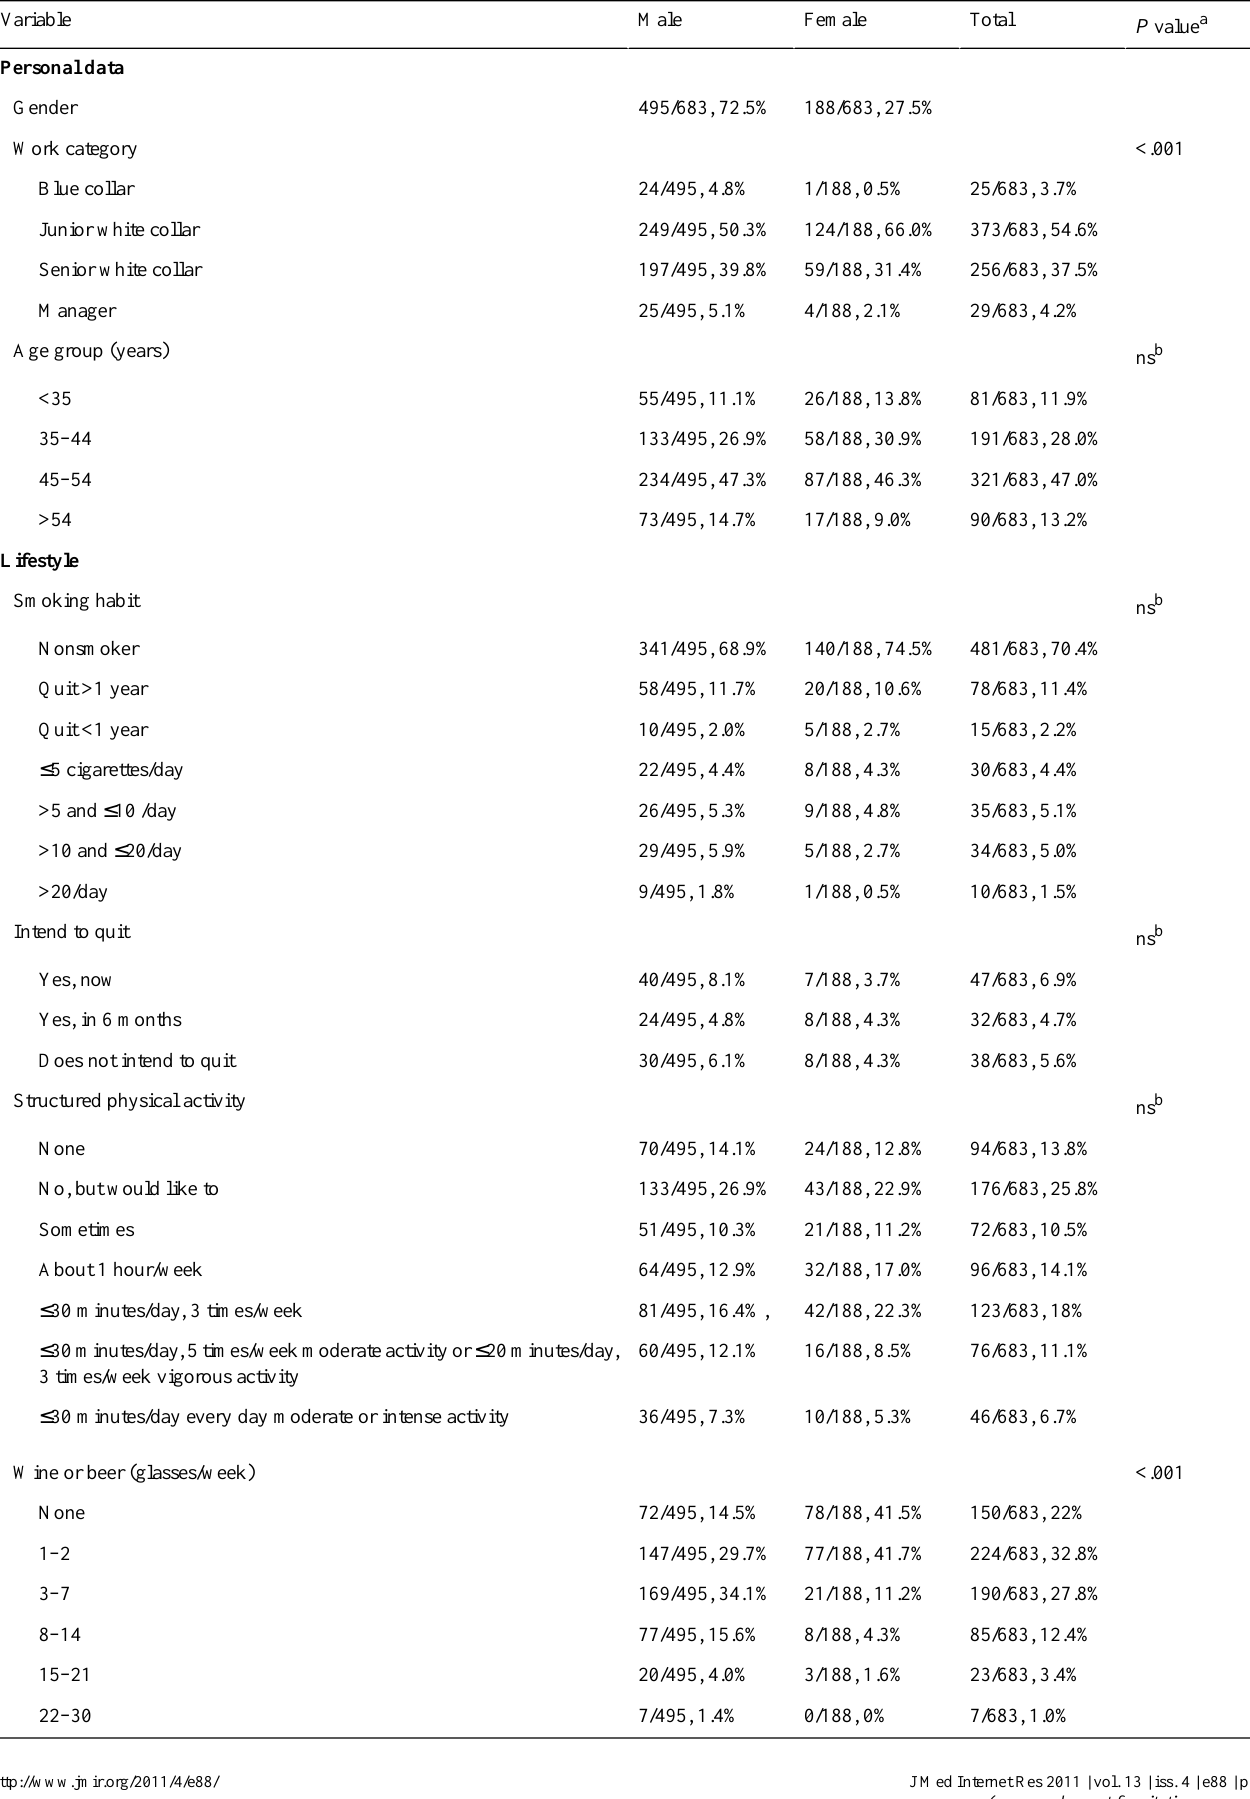
Table 1. Distribution of data (N = 683 participants): total and within-gender